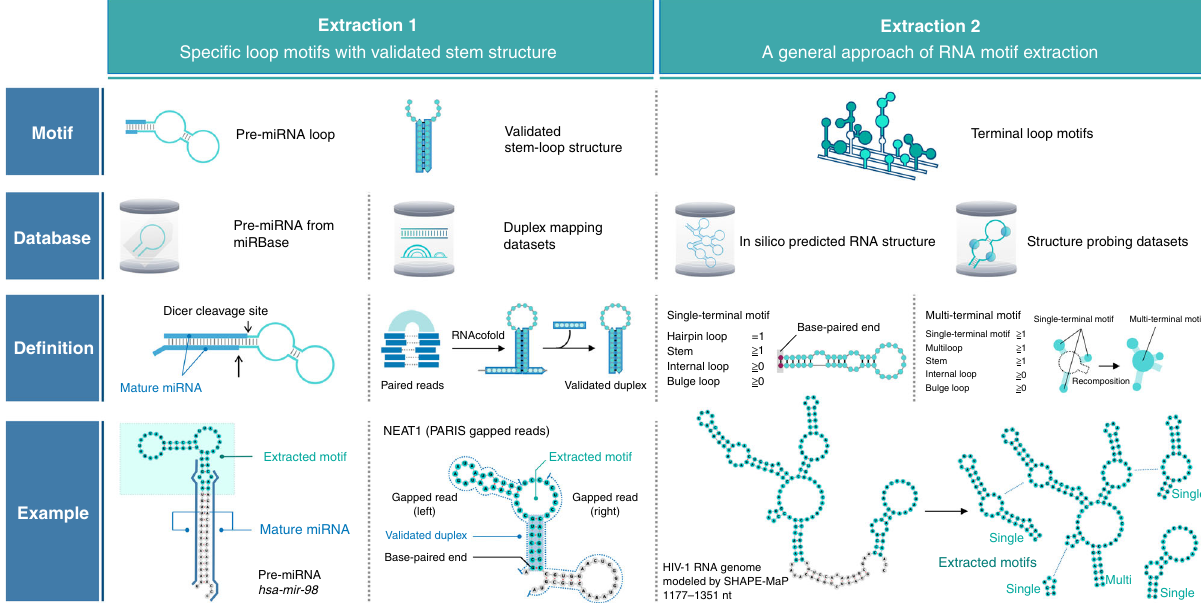
Fig. 2 Structural motif extraction for the RNA structure library. Motif extraction obtains RNA structures from datasets to design the RNA structure library in FOREST. Extraction 1: A method to extract a validated stem – loop structure. In this study, pre-miRNA, a region surrounded by mature miRNAs, was recognized as a validated stem-loop motif, and the loop region with a part of the stem was extracted from human pre-miRNAs registered in miRBase. The Dicer cleavage site determined the boundary of the extracted pre-miRNA loop motif. We also extracted experimentally validated RNA stems from the data set of the high-throughput mapping method for RNA – RNA interactions. Extraction 2: A method for extracting terminal loop motifs from long and continuous RNAs. The extraction method comprehensively extracts single-terminal loop motifs de fi ned as a single hairpin loop and its associated stem motifs (including internal loops and bulge loops). Subsequently, recognition of the combination of multiple single terminal loops can recon fi gure and extract multi-terminal loops. The examples are representative motifs selected from the libraries conducted in this study (maximum length of the structure region: 116 nt). See also Supplementary Figs. 2 – 4.